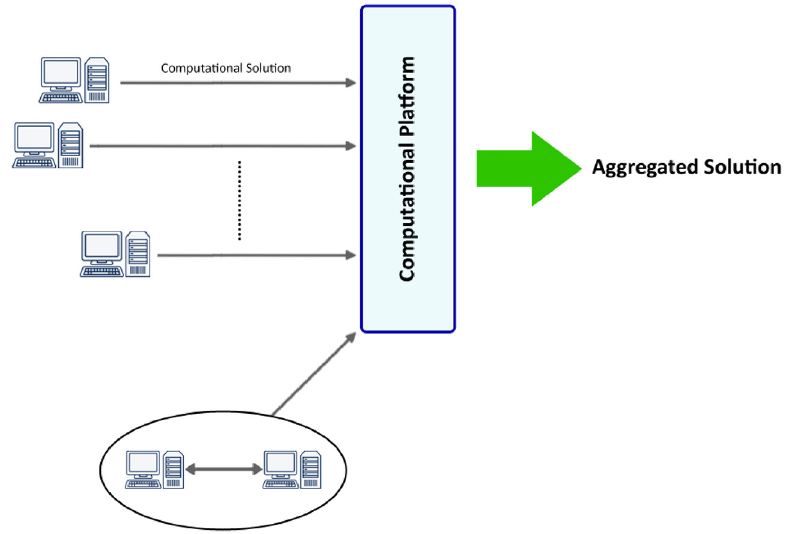
Figure 2. Simpli fi ed schematic of CMI work fl